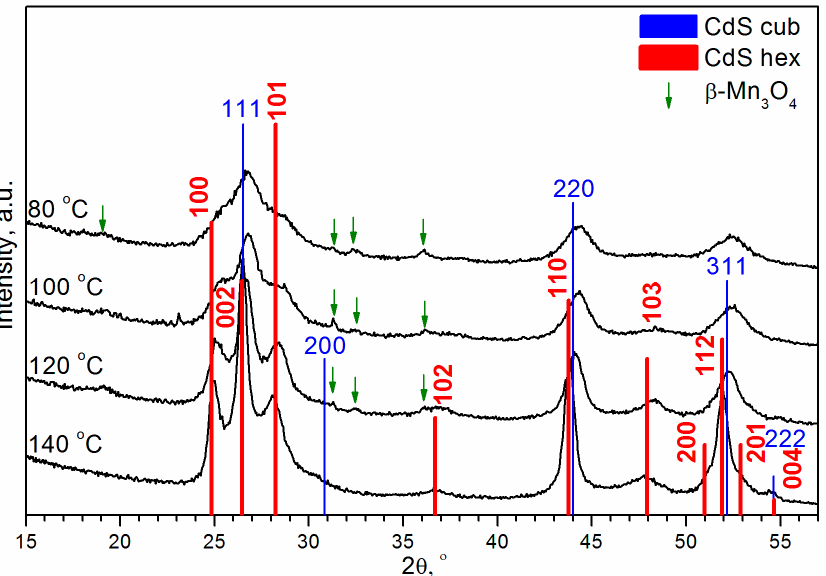
Figure 2. Experimental XRD patterns of (Cd,Mn)S-based photocatalysts prepared by hydrothermal synthesis (HTS) at different temperatures.